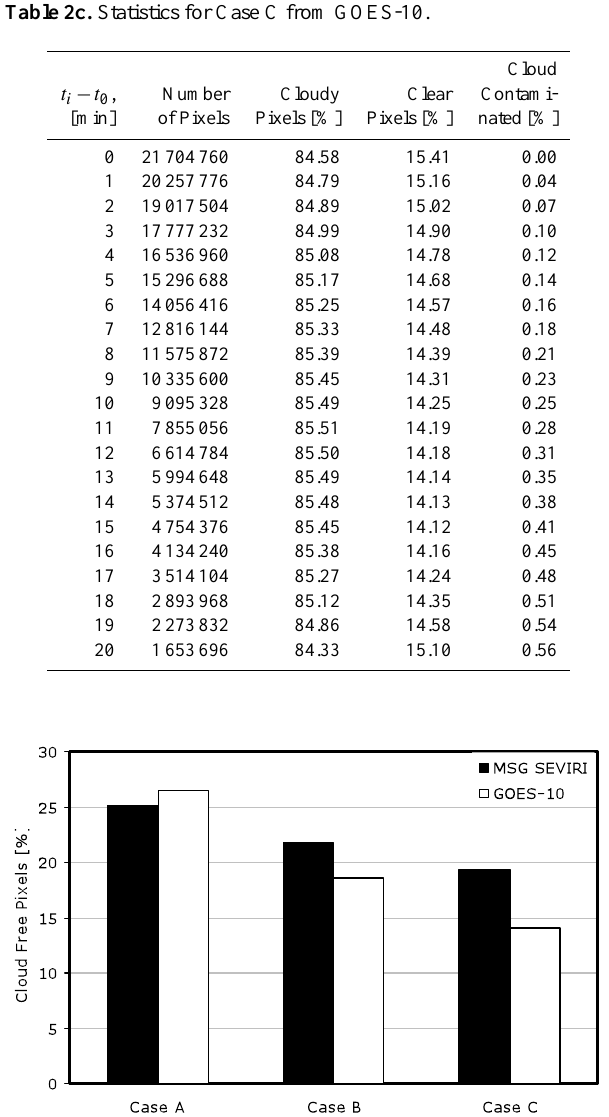
Table 2c. Statistics for Case C from GOES-10.